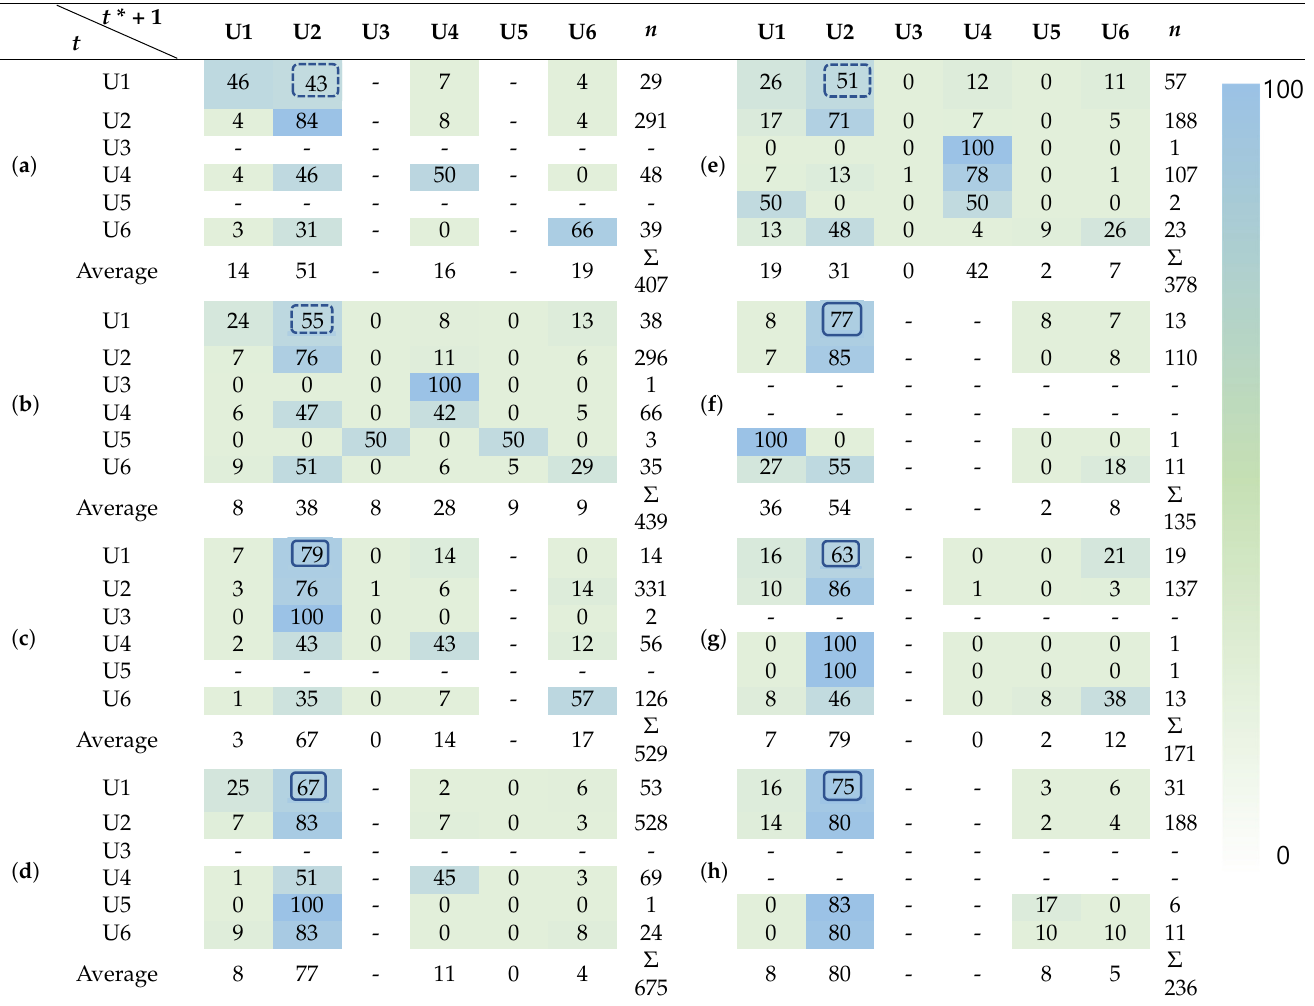
Table 2. TPMs (in percent) of visiting habitats with different resources (forest, leaf type, and water) by wild boar individuals in different life stages: ( a ) #67M_Fer., ( b ) #67M_Peri., ( c ) #67M_Brood., ( d ) #67M_Mati., ( e ) #05M_Peri., ( f ) #06M_Brood., ( g ) #68M_Brood., and ( h ) #68M_Mati. (Symbol, “-“, within the table indicating no-observation; Colorbar assisting visualization of probability levels).